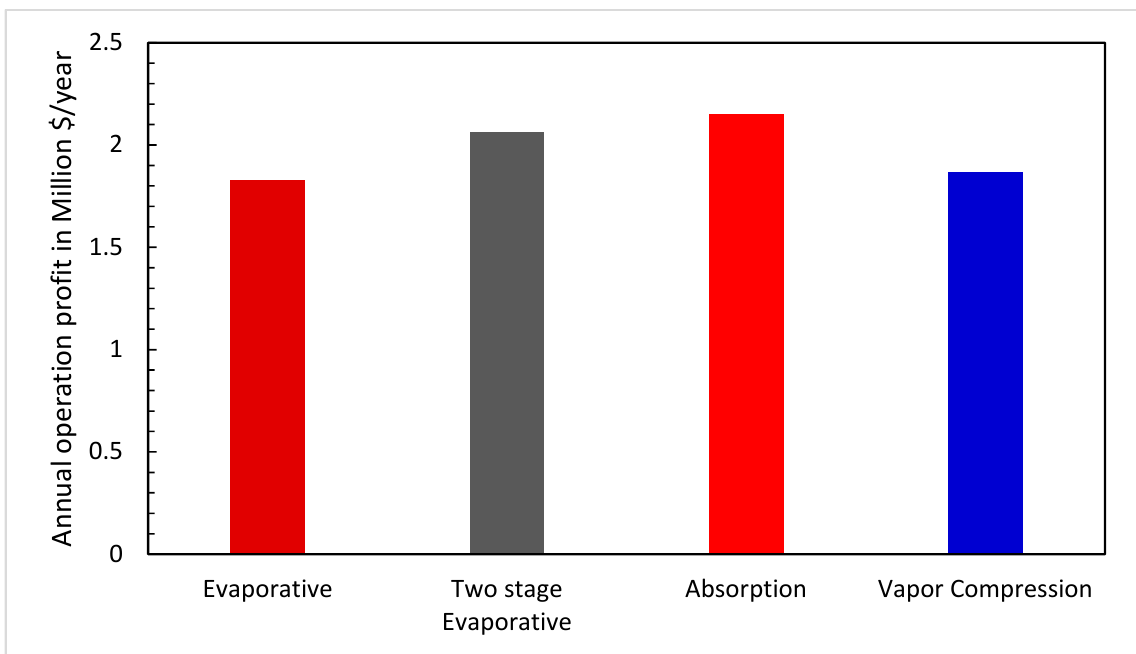
Figure 21. Annual added profit.